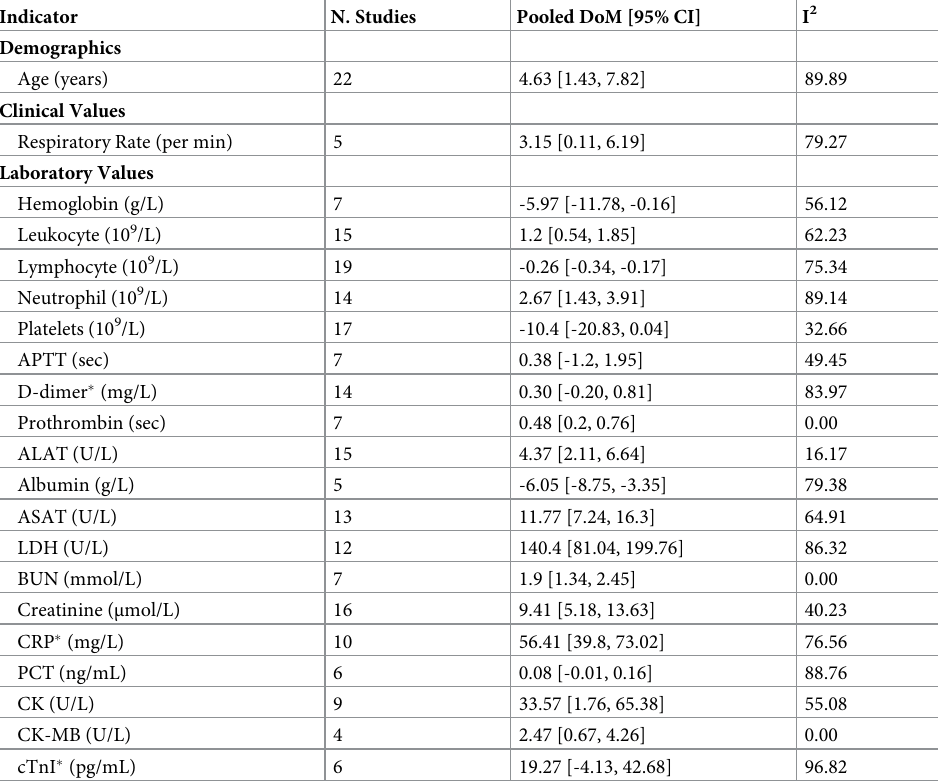
� Indicates that the DL approach was used to estimate between-study heterogeneity. APTT = activated partial thrombin time; ALAT = Alanine transaminase; ASAT = Aspartate transaminase; LDH = Lactate dehydrogenase; BUN = Blood urea nitrogen; CRP = C-reactive protein; PCT = Procalcitonin CK = Creatine kinase; CK-MB = Creatine kinase–myocardial band; TnI = cardiac Troponin I.